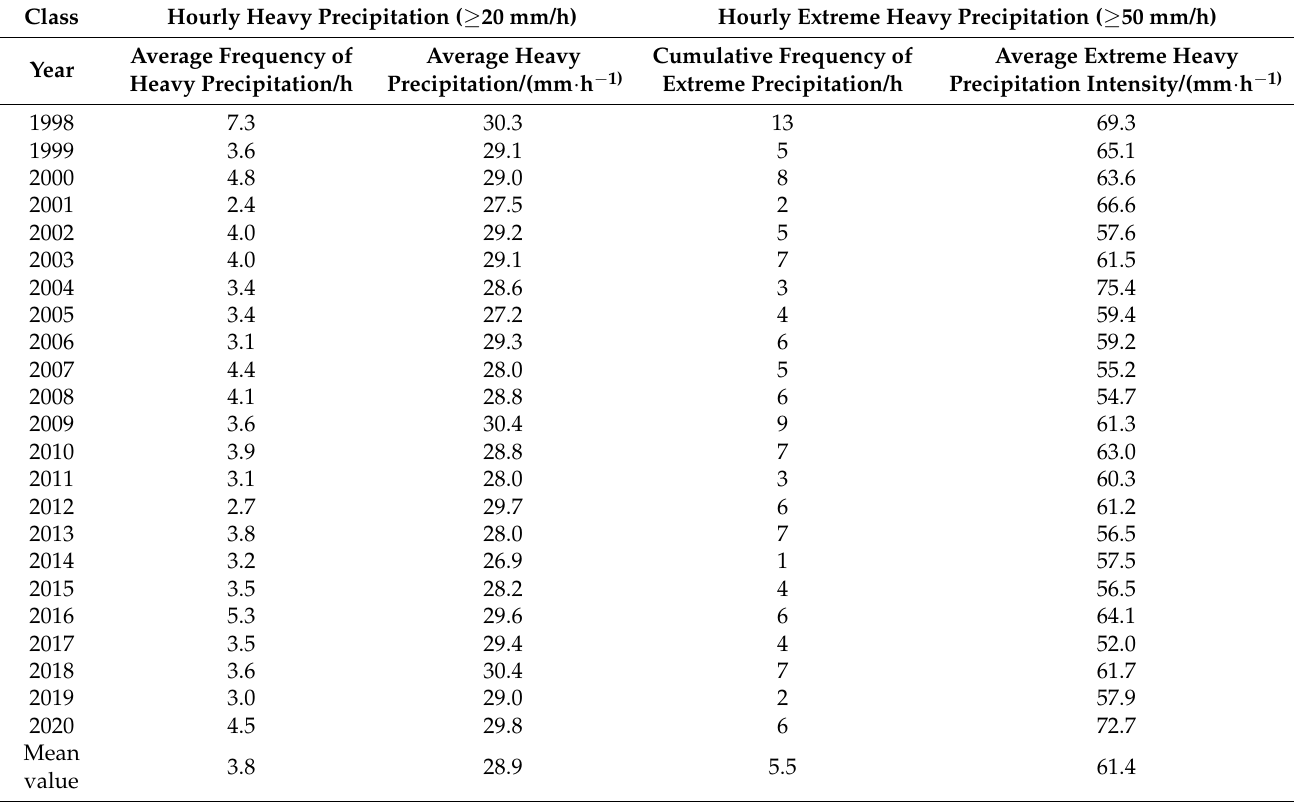
Table 2. Statistical table of precipitation frequency and average intensity of hourly heavy precipitation ( ≥ 20 mm/h) and hourly extreme heavy precipitation ( ≥ 50 mm/h) from 1998 to 2020.